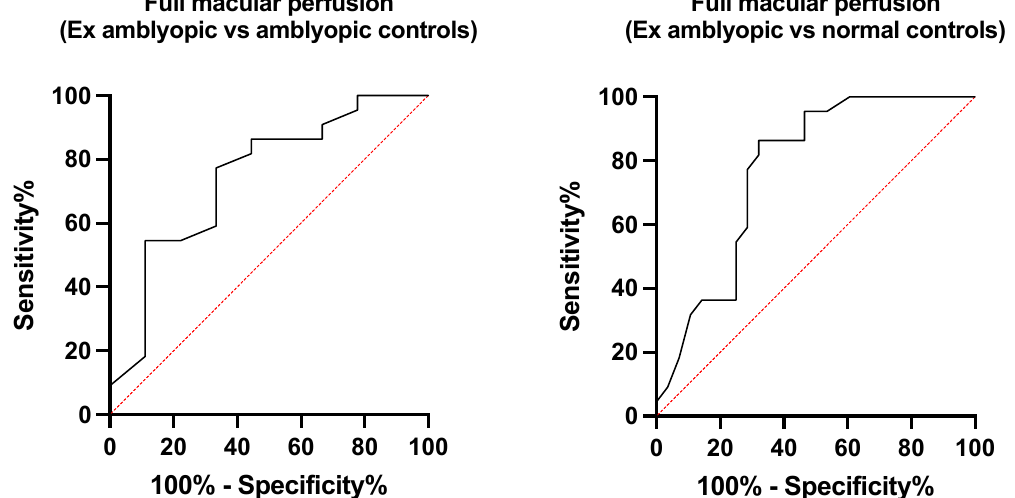
Figure 3. ROC curves showing performances of OCTA macular perfusion in differentiating ex amblyopic eyes from amblyopic eyes (AUC = 0.74) and normal eyes (AUC = 0.77).